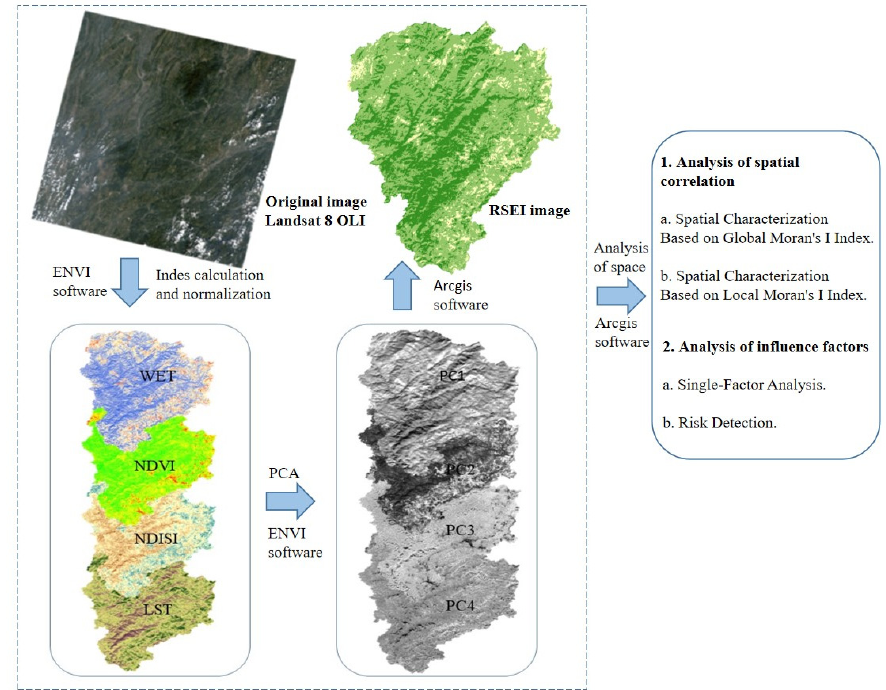
Figure 2. Methodological framework for the ecological quality analysis of the Shibing Karst.